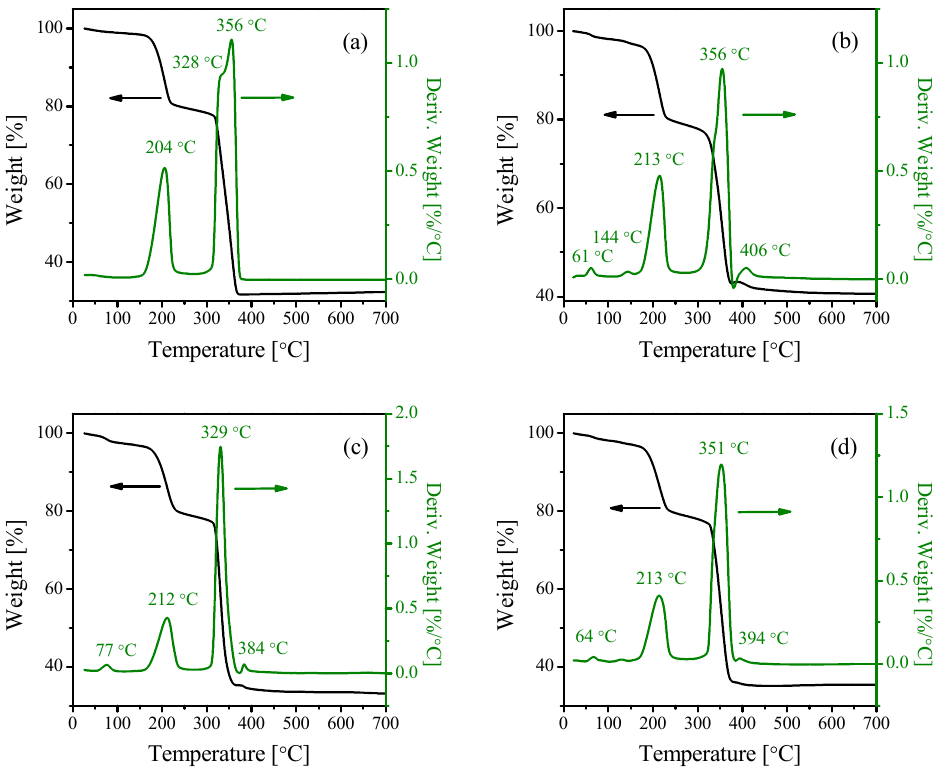
Figure 1. TGA thermograms for Ni ‐ oxalate. ( a ); Gd/Ni ‐ oxalate ( b ); La/Ni ‐ oxalate ( c ); and Sm/Ni ‐ oxalate ( d ).